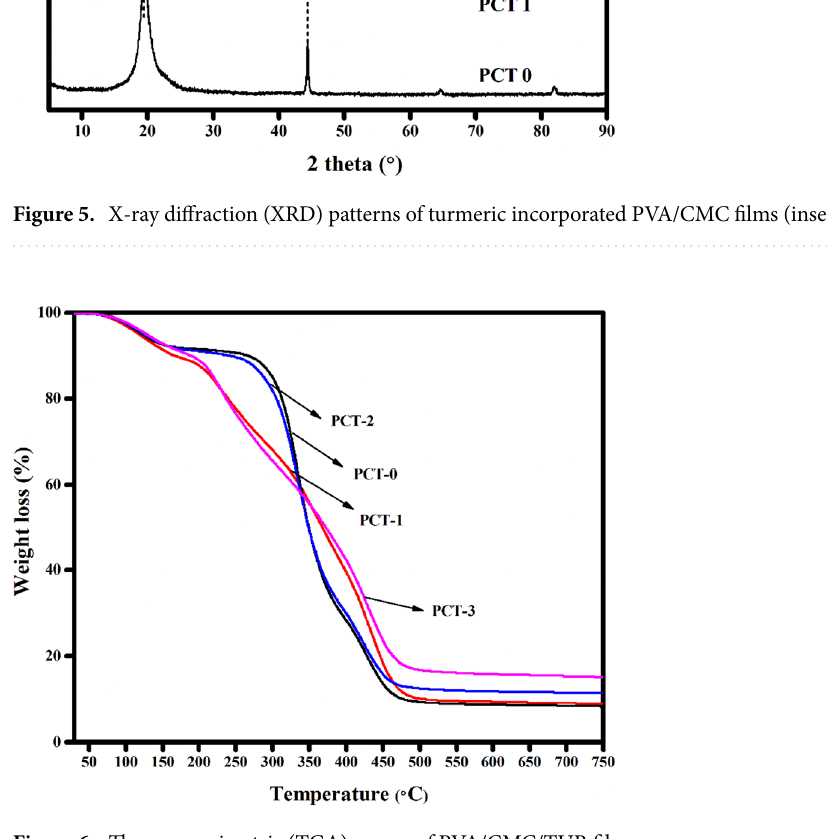
Figure 6. Thermogravimetric (TGA) curves of PVA/CMC/TUR